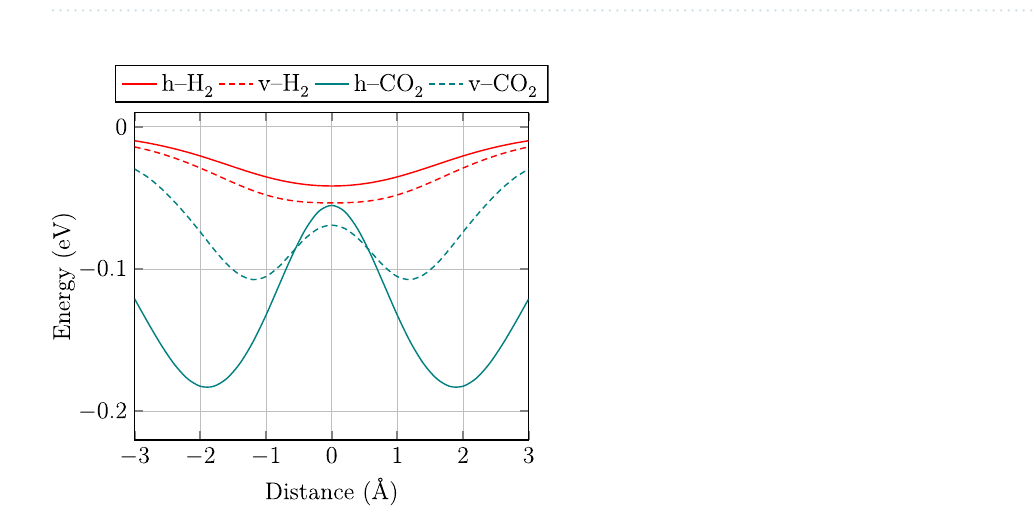
Figure 2. Radial distribution functions between N atoms of 1,3,5-TAB and C and O atoms of CO 2 .